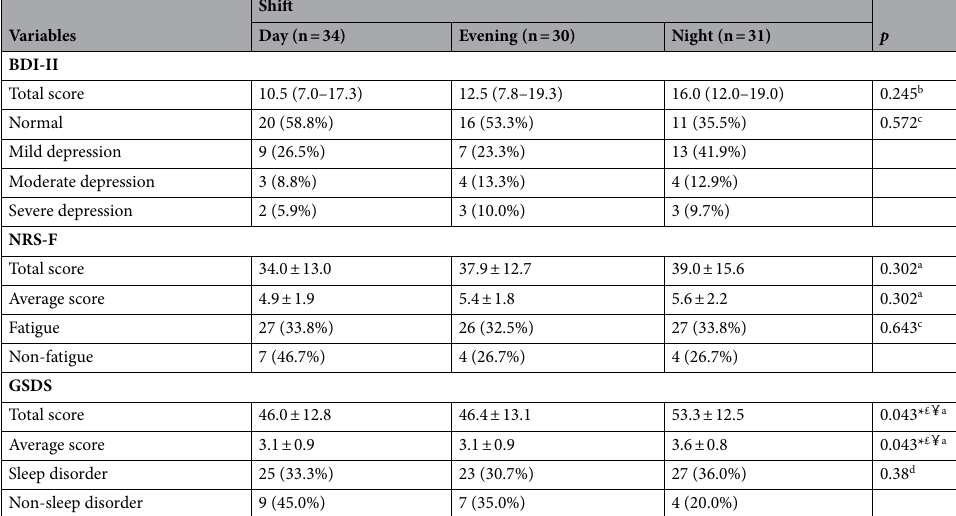
Table 5. Participant questionnaire score of three class shift nurses. BDI-II, Beck Depression Inventory II; NRS-F, Numerical Rating Scale for Fatigue; GSDS, General Sleep Disturbance Scale. * p -value < 0.05( §